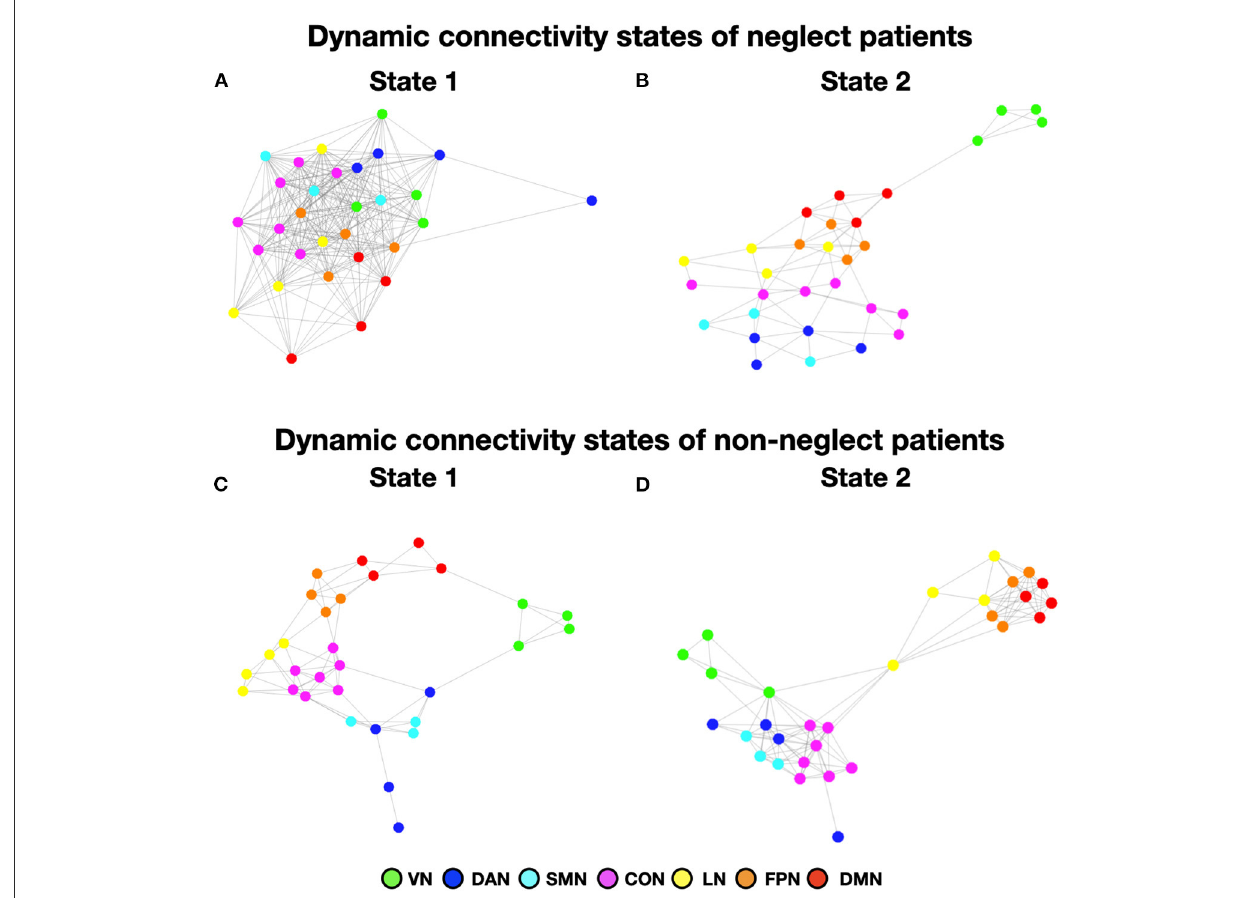
FIGURE5 Dynamic connectivity states of neglect and non-neglect patients. (A, B) Show the spring-embedded representation of the centroid of the functional network connectivity states identified in the sub-cohort of neglect patients. In contrast, (C, D) refer to those of non-neglect patients. Abbreviations as in Figure